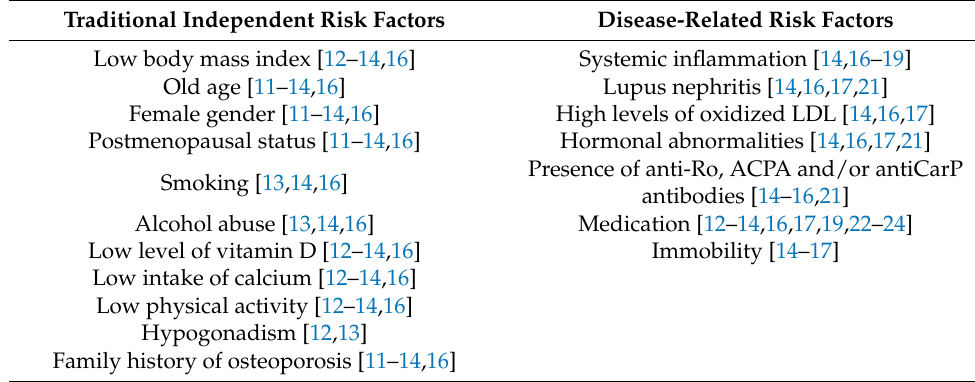
Table 1. Osteoporosis risk factors in